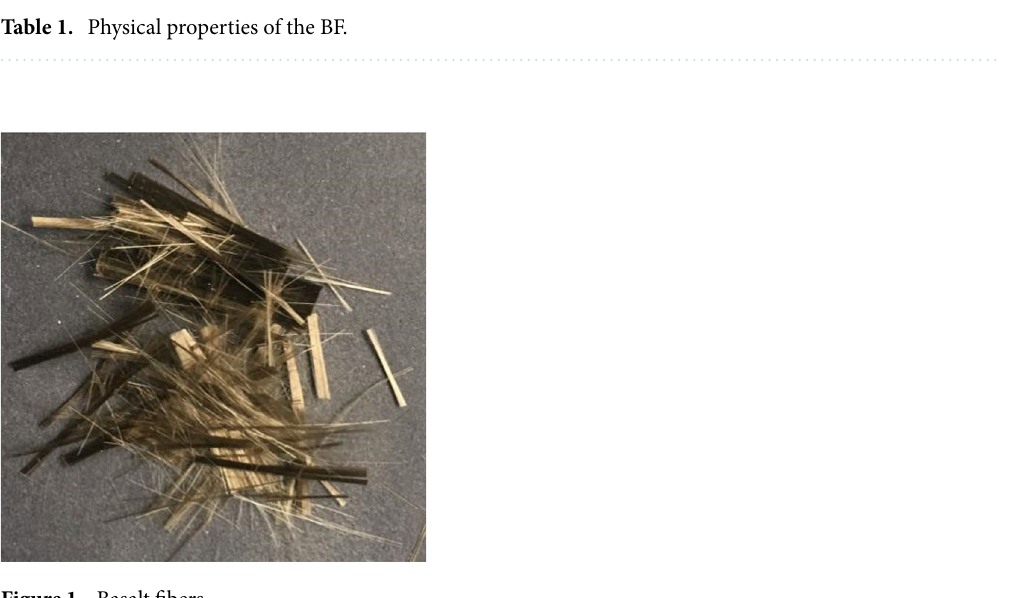
Figure 1. Basalt